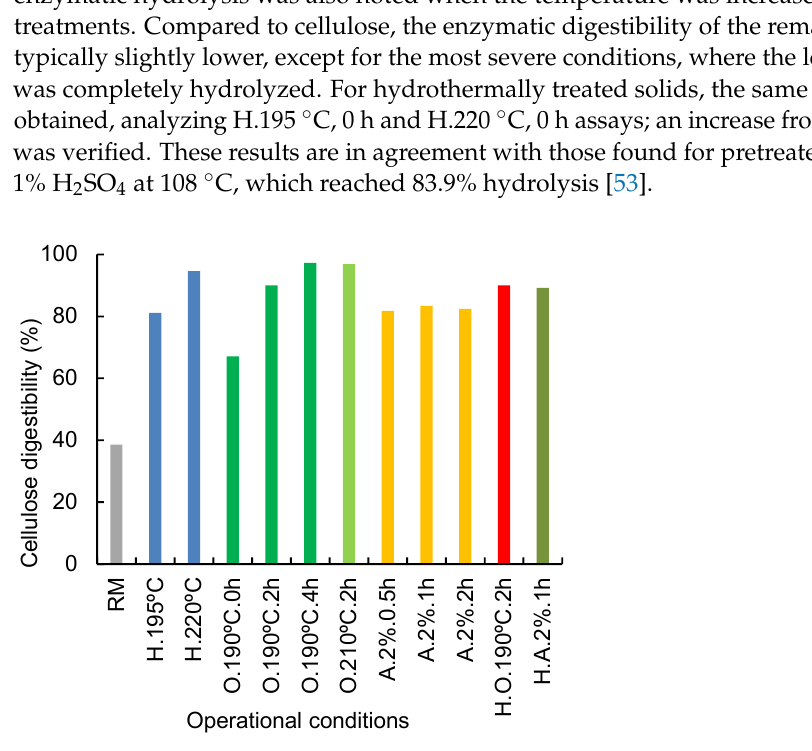
Figure 2. Enzymatic digestibility (g/100 g glucan) of raw corn cobs and selected solids resulting from Figure 2 - Enzymatic digestibility (g/100 g glucan) of raw corn cobs and selected solids several assays. (RM—Raw material; H.—autohydrolysis, O.—Organosolv, A.—Alkaline